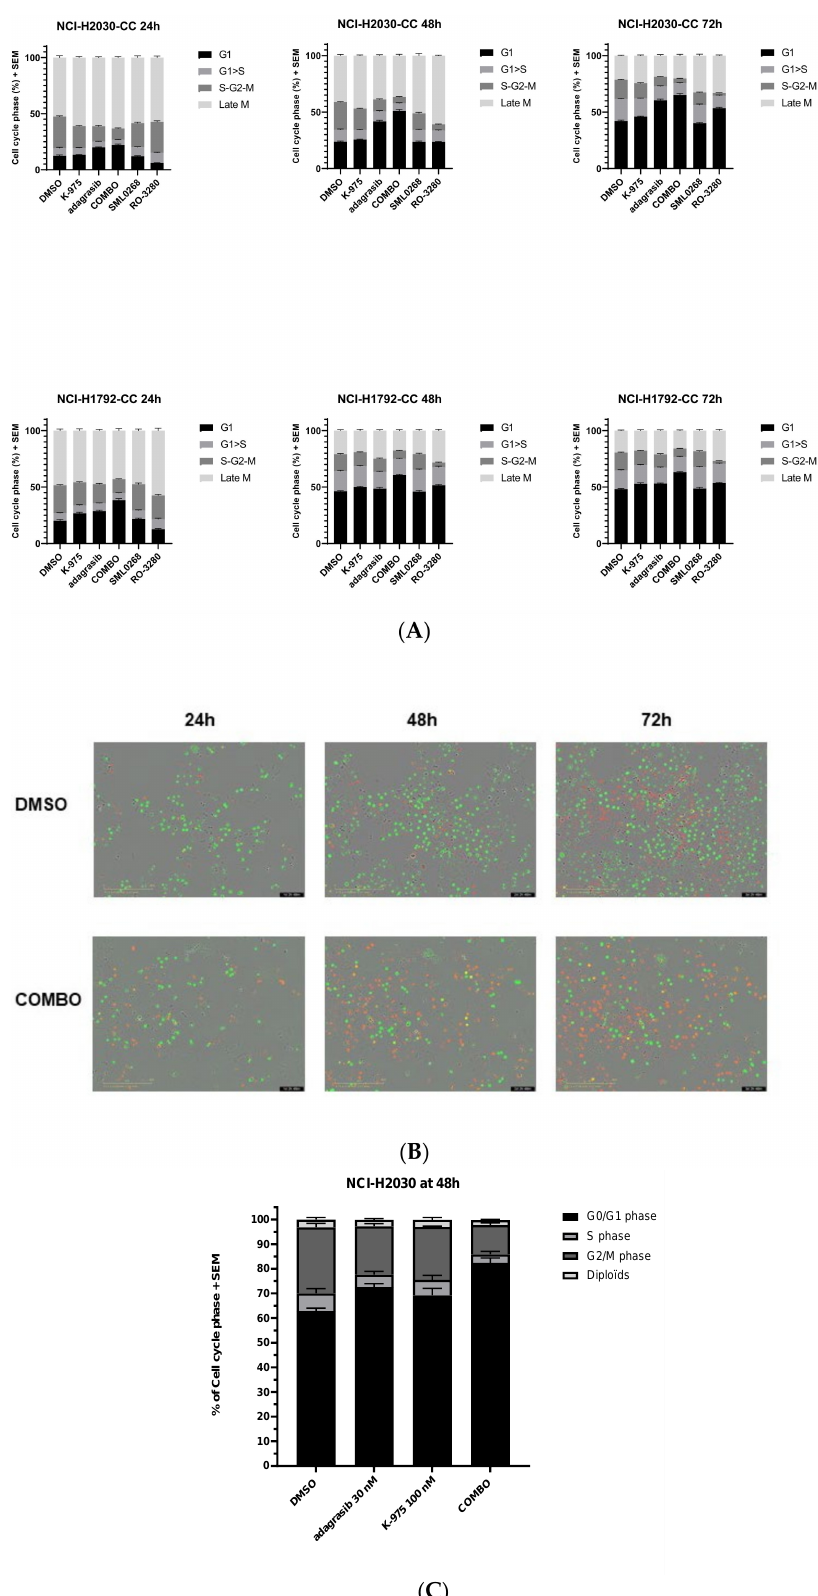
Figure 5. Cell cycle analysis and FACS detection show an arrest in the G0/G1 and G2/M phases. ( A ) Time course on cell cycle analysis. Histograms representing different phases of the cell cycle. The analysis was performed using NCI-H2030 (NCI-H2030-CC) and NCI-H1792 (NCI-H1792-CC) mod- ified with lentivirus (Sartorius). The conditions analyzed were DMSO, K-975 at 100 nM, adagrasib at 30 nM, and COMBO (adagrasib and K-975 at the selected doses). Representative figures from at least two biological replicates (BR) of the different conditions were analyzed at 24, 48, and 72 h. Aurora B Kinase (SML0268) and PLK1 (RO-3280) inhibitors were used as control. Cell cycle phases analyzed were: G1, G1 > S (Transition), S-G2-M, and Late M. ( B ) Representative photos of time course on NCI-H2030-CC cell line. Conditions analyzed: DMSO and COMBO. The cell carpet is represented by cycling cells (green cells), while in the combination, the cell-confluency is rarer, and the cells are arrested in G1 (red cells). Details are described in Section 4. ( C ) Cell cycle analysis via FACS procedure at 48 h. Validation via propidium iodide of the DNA content. Conditions analyzed: DMSO, K-975 (100 nM), adagrasib (30 nM), COMBO (adagrasib and K-975). The image represents three biological replicates. 2.5. Sanofi Proprietary TEADi Ameliorates Adagrasib Activity by Reducing Tumor Cell Growth in NSCLC Cell Line KRAS G12C NCI-H358 We decided to confirm our results in an in vivo study. To this end, we first evaluated the tumor formation of NCI-H2030, HOP 62, H1792, and NCI-H358 cell lines implanted as subcutaneous models in vivo. Among these four cell lines tested, only the NCI-H358 cell line led to rapid tumor formation in vivo and was selected as the xenograft model of choice for in vivo evaluation of the KRAS G12C i-TEADi combination. We then selected the best compounds to use for this study. While K-975 is an efficacious tool compound for in vitro studies, this molecule is suboptimal for in vivo combination studies due to its strong CYP-induction potential. We therefore decided to use the Sanofi TEADi here, called Cpd A, as a TEADi for this in vivo drug combination study. Cpd A also binds to the central lipid pocket of TEAD(1-4) proteins such as K-975 and exerts equal potency in relevant cellular assays (data not shown). However, it does not affect CYP induction or inhibition and is better suited for in vivo combination experiments. After a first in vitro evaluation in which we confirmed that the combined effect of Cpd A with adagrasib compares to what we previously observed for K-975 (Supplemen- tary figure S5), we tested this compound in vivo alone and in combination with adagrasib. Similar to our cellular results, while Cpd A was inactive when tested as a single agent at 25 mg/kg QD, and adagrasib tested at 10 mg/kg QD was marginally active, the combina- tion of Cpd A with adagrasib demonstrated significantly superior activity compared to adagrasib alone ( p value < 0.0001; Figure 6). We thus confirmed the beneficial effect of a TEAD inhibitor in vivo on adagrasib-mediated growth inhibition.